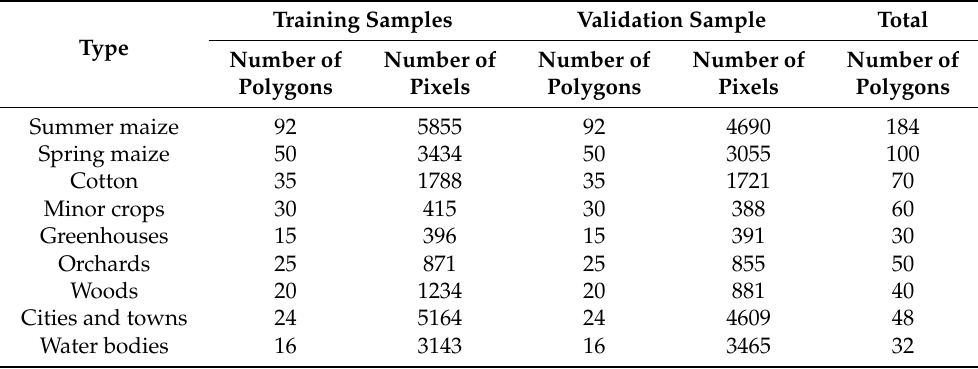
Table 2. Number of samples for different